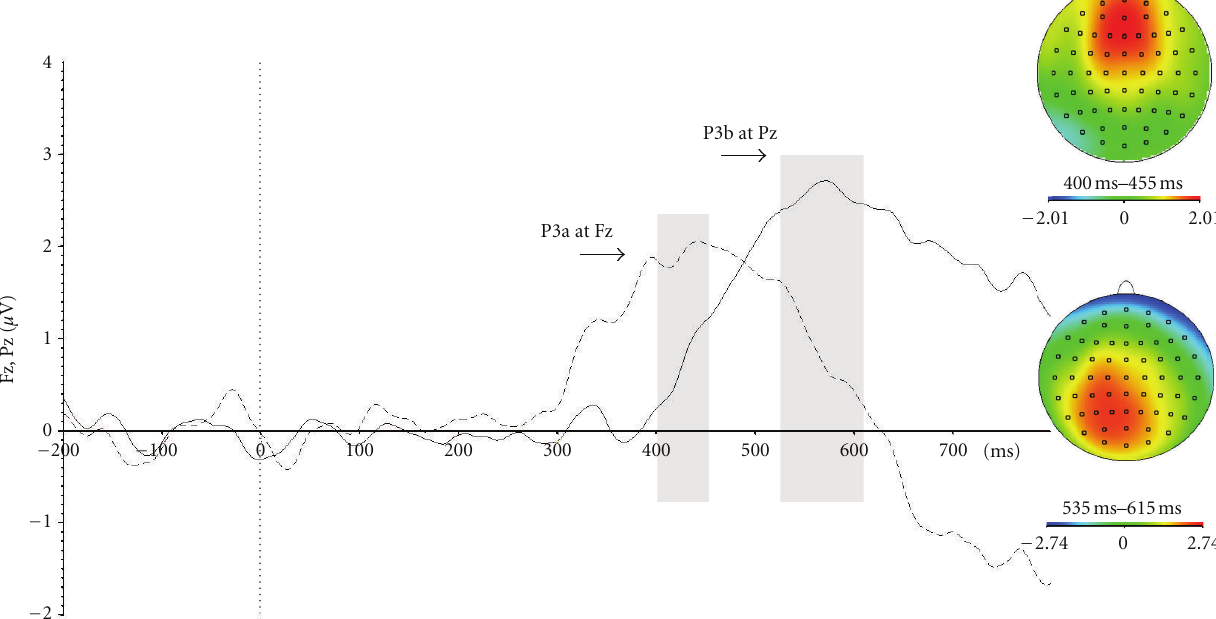
Figure 4: Event-related potentials that isolate the P3a and P3b components from averages that take into account the side of the target stimulus (in target-present trials). We subtracted the average waveform from the frequent-target, frequent-position, condition (the most frequently-occurring condition) from the rare-position condition; the solid line shows this di ff erence wave at Pz, while the dashed line shows this di ff erence at